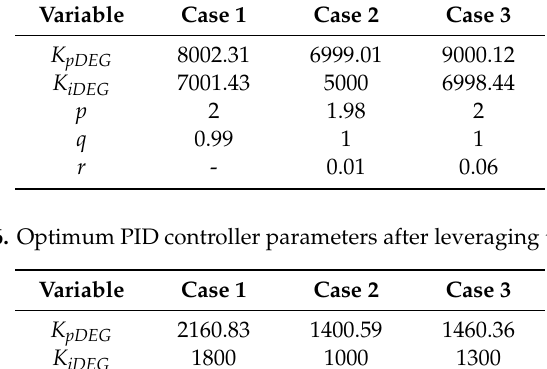
Table 5. Optimum PI controller parameters after leveraging the FPA.